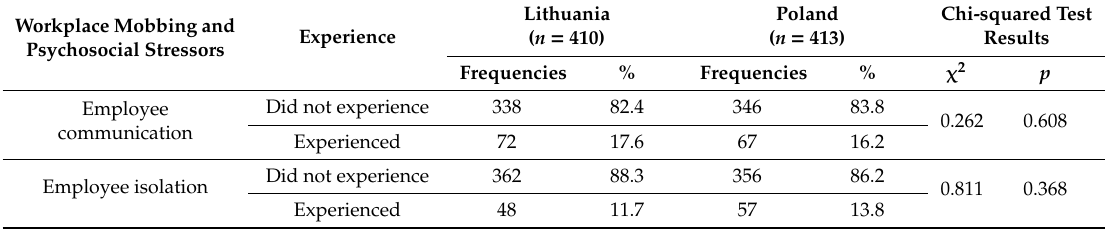
Table 5. Workplace mobbing and psychosocial stressors in Lithuanian and Polish organizations: the subscale